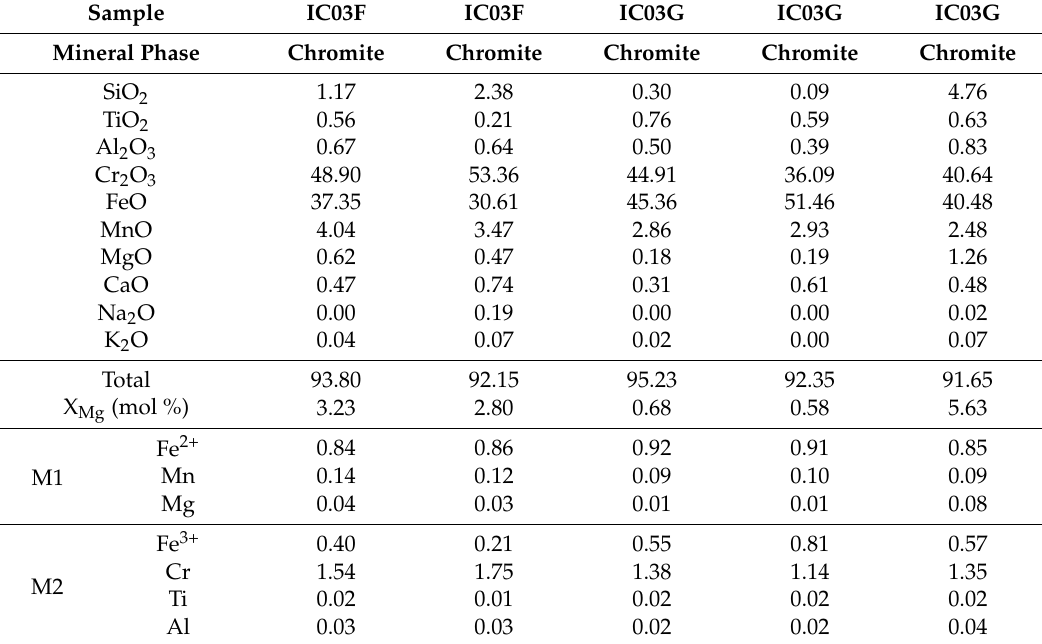
Table 3. EMPA analyses and structural formulae of chromites from this